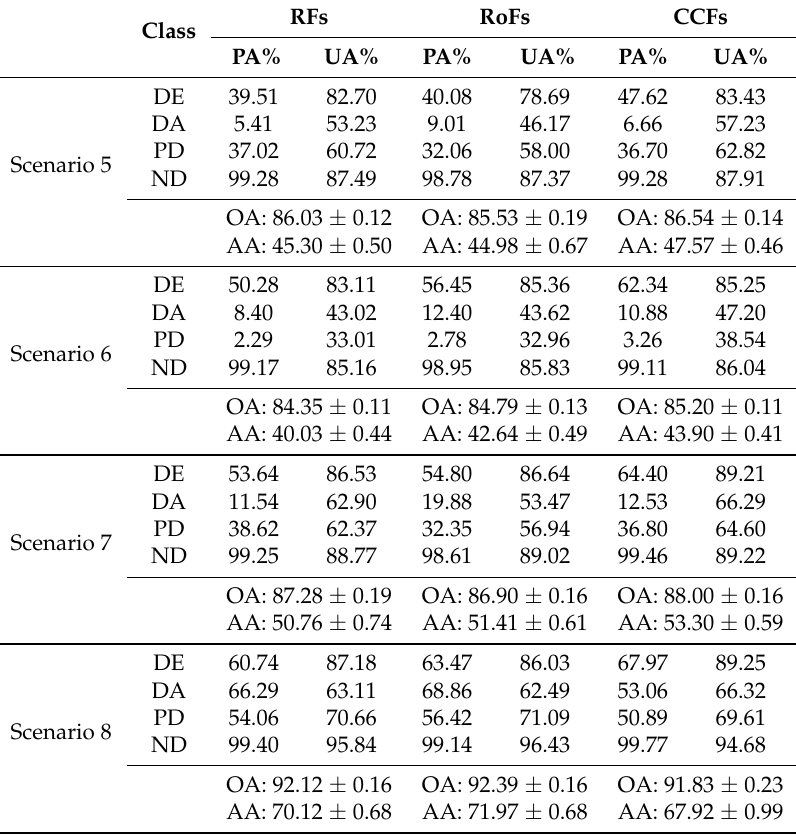
Table 5. Classification accuracies achieved from 20 random trials by using RFs, RoFs and CCFs classifiers. The input feature combinations derived from post- and pre-event datasets covers Scenarios